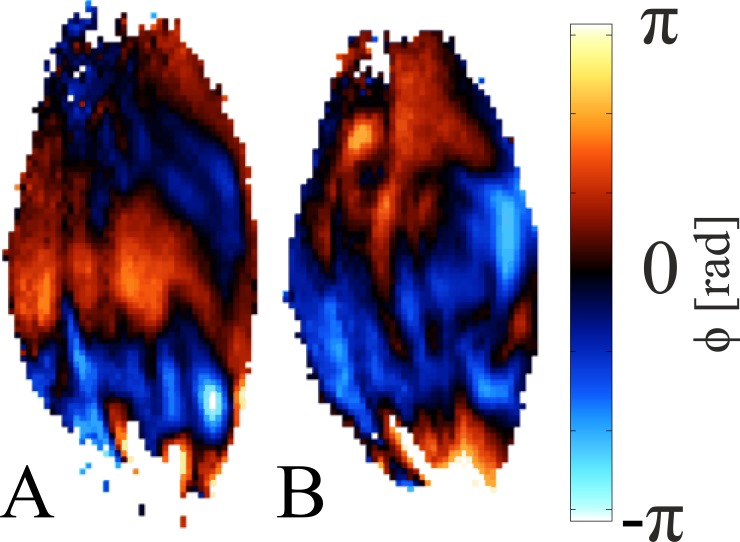
MRE pre and post indentation.Snapshot of a 16 offset 900 Hz SE-EPI-MRE (A) before and (B) after indentation.